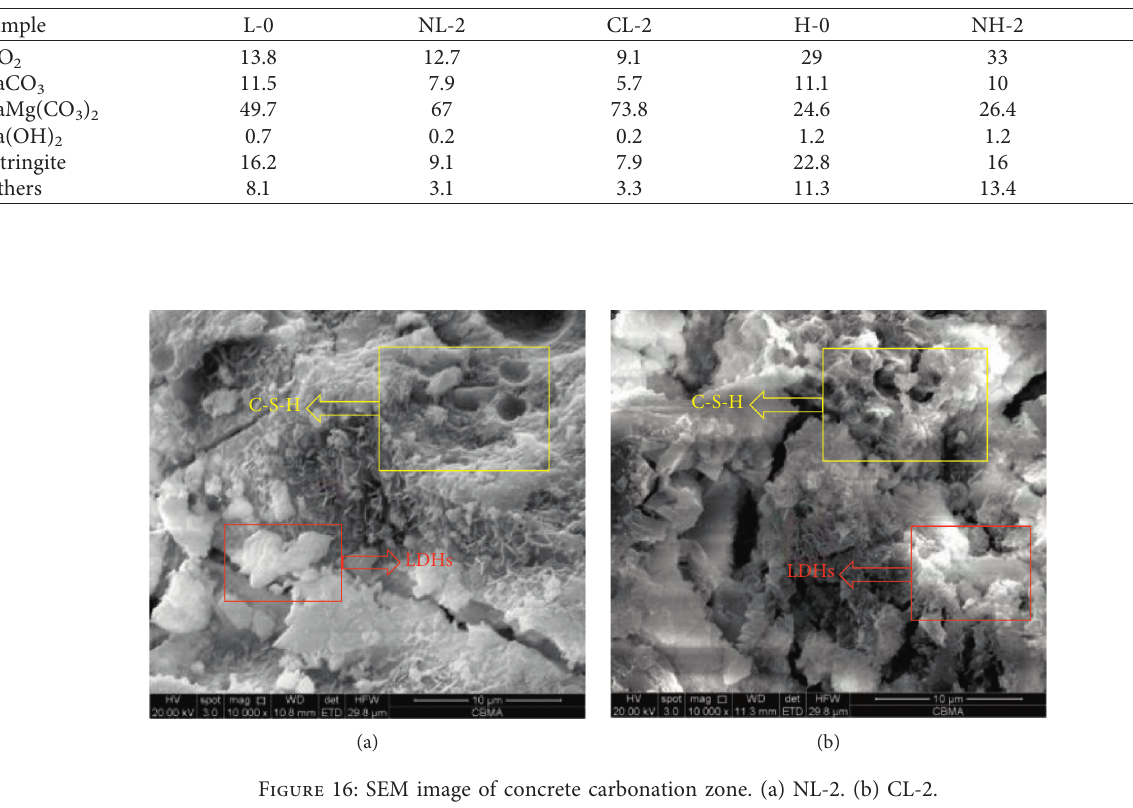
Table 8: Mass fraction of each substance in concrete carbonation zone (%).